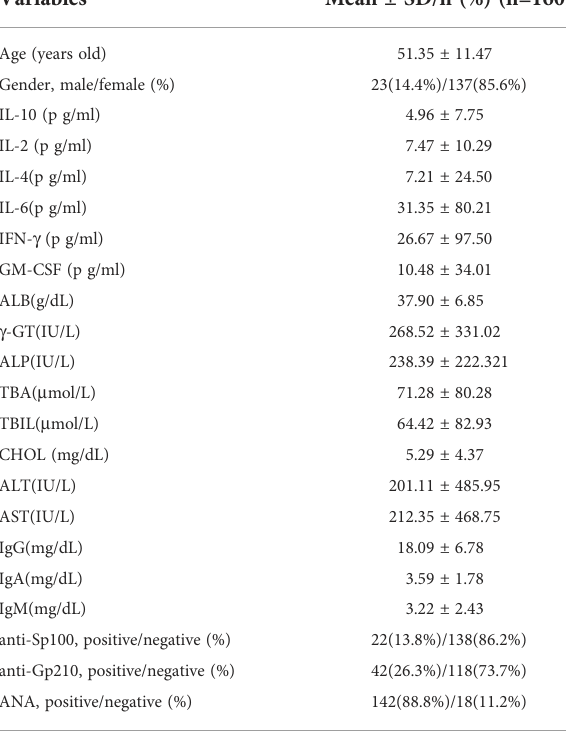
TABLE 1 Baseline information and laboratory parameters of PBC